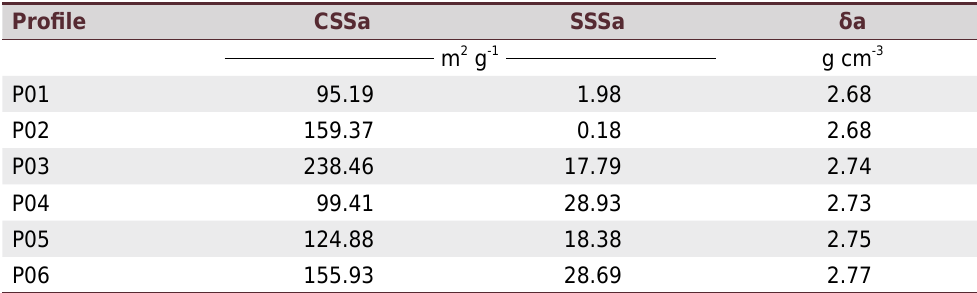
diagnostic horizons of each soil (Table 1), whose physical (Table 2), chemical (Table 3), and mineralogical (Table 4) attributes had been previously determined. All selected horizons presented vertic properties, such as prismatic structure formation, cracks, Table 2. Physical properties of the six Vertisols sampled in Bahia State